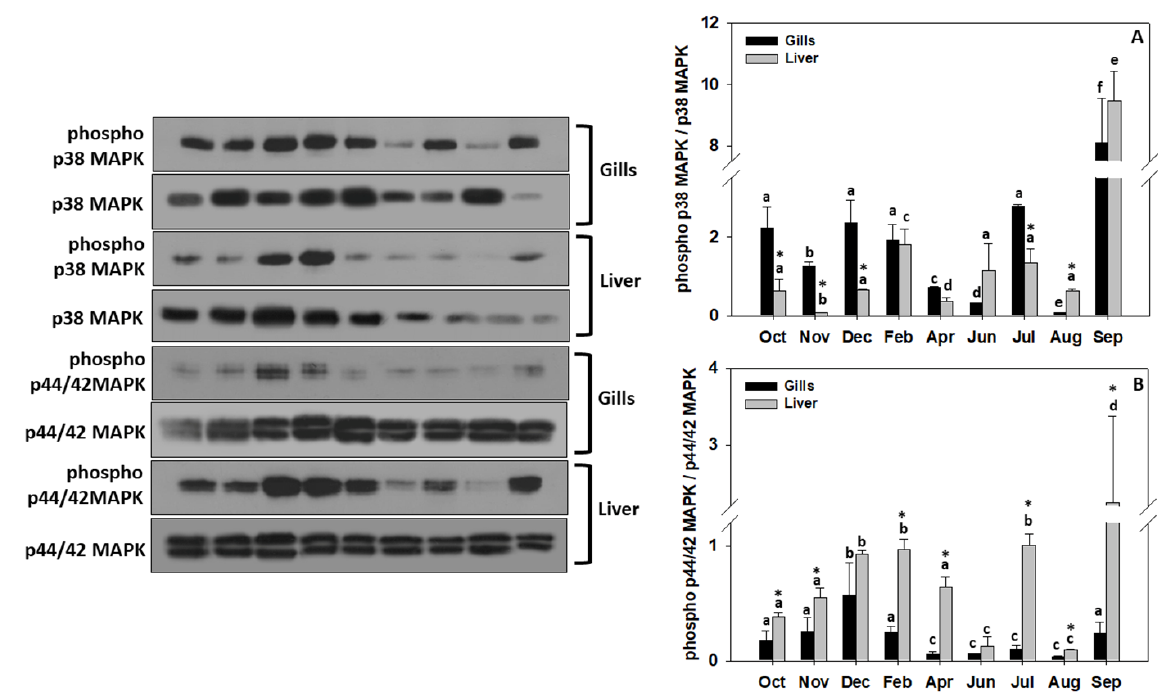
Figure 6. Phosphorylation ratio levels (mean ± SD) of ( A ) p38 MAPK (phospho p38 MAPK/p38 MAPK) and ( B ) p44/42 MAPK (phospho p44/42 MAPK/p44/42 MAPK) in the gills and liver ( n = 5) of Alburnus vistonicus in Vistonis lake (Northern Greece), during the sampling period (October 2014–September 2015). Samplings were performed on a monthly basis. Representative blots are presented. Significant differences ( p < 0.05) are presented as: lower case letters—between sampling months and *—between gills and liver. No sampling was conducted in January 2015.